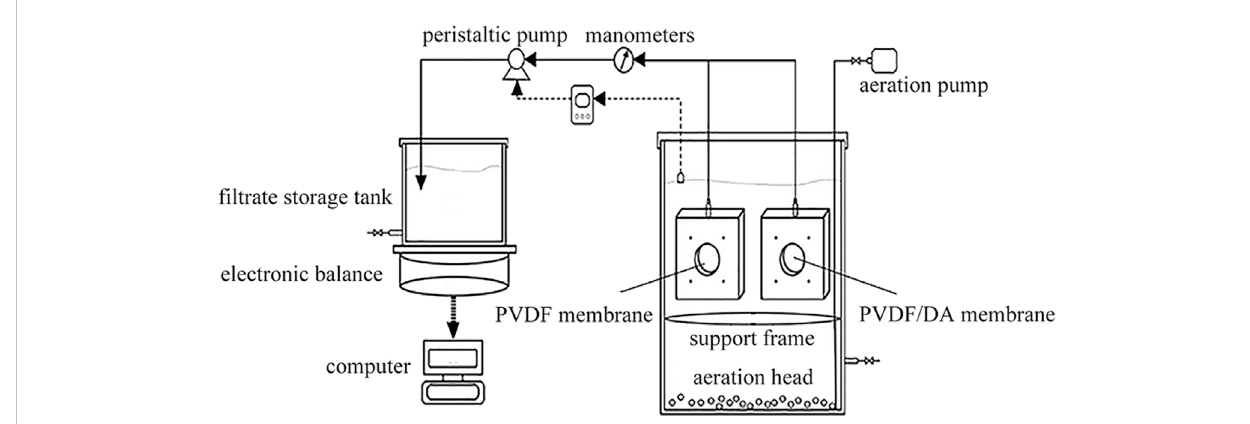
FIGURE 2 Schematic diagram of the MBR experimental